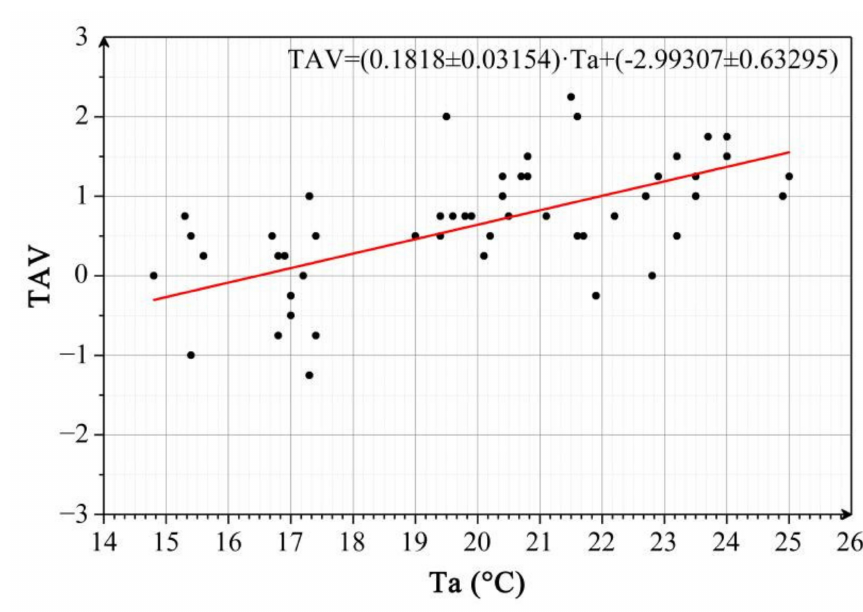
Figure 13. The quantitative relationship between TAV and